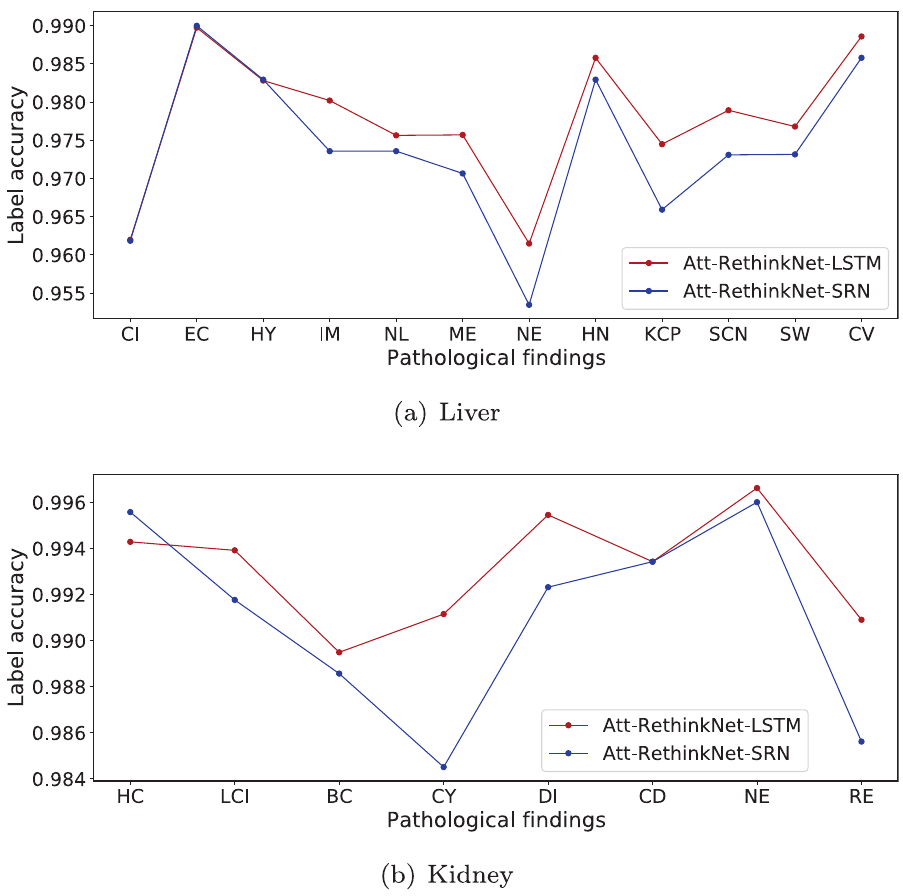
Fig 5. The ACC lab of deep learning experiments in liver data (a) and kidney data (b).